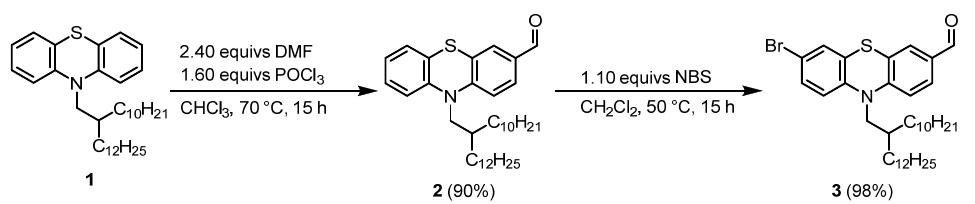
Figure 1. Synthesis of 7-bromo-10-(2-decyl-tetradecyl)-10 H -phenothiazine-3-carbaldehyde ( 3 ) in a two-step sequence of Vilsmeier–Haack formylation and NBS bromination.